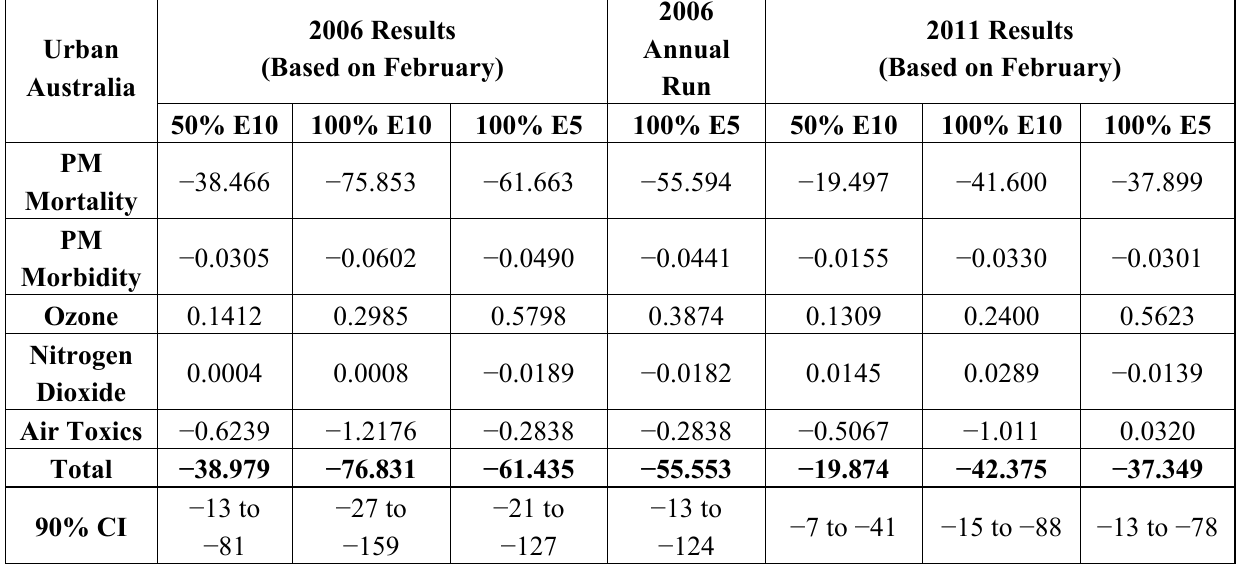
Table 3. Indicative Summary Table of Increases in Annual Baseline Health Cost (2007$millions, 90% Confidence Intervals) for Urban Australia